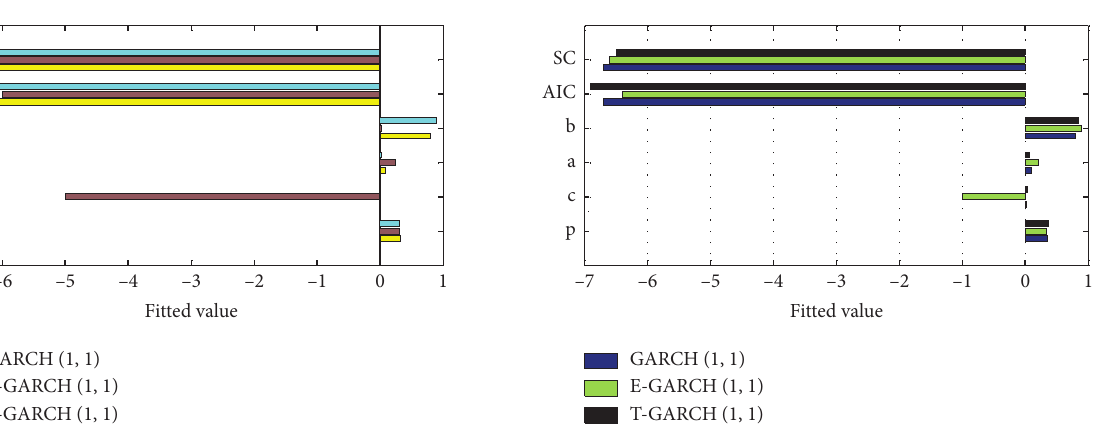
Figure 10: GARCH model fitting parameter diagram of supply chain financial inventory portfolio price change sequence.